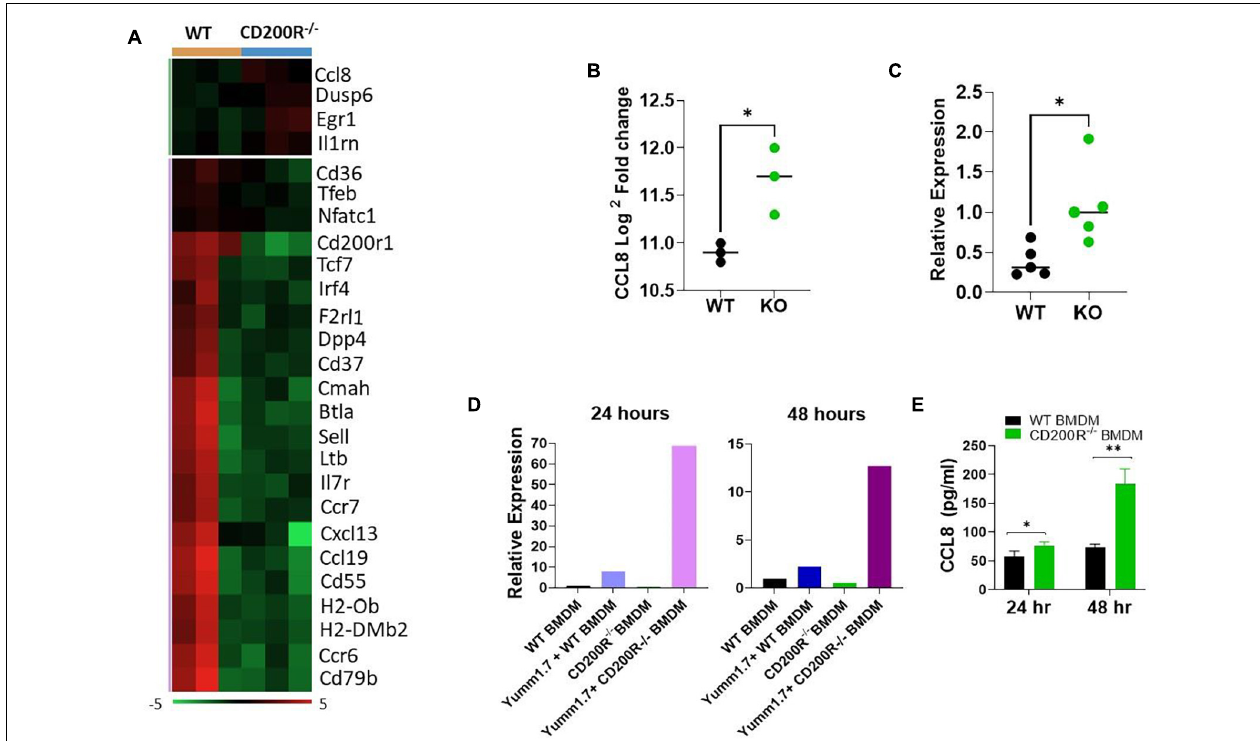
FIGURE 3 | Deficiency of CD200R signaling alters TME and upregulates CCL8. (A) Heat map of all differentially expressed genes based on the Nanostring analysis. (B) CCL8 gene expression was significantly elevated in CD200R − / − vs. wild type tumors based on the Nanostring analysis ( ∗ P = 0.022 by two-sided Student’s t -test). (C) qPCR was used to quantify CCL8 gene expression in tumors ( n = 5/group) from wild type vs. CD200R − / − mice. ∗ P = 0.042 by two-sided STUDENT’s t -test. (D,E) Bone marrow derive macrophages (BMDM) was generated and co-cultured with YUMM1.7 tumor cells. qPCR was used to quantify CCL8 gene (D) expression in macrophages, and ELISA was used to quantify CCL8 protein (E) production in culture supernatants. CCL8 gene expression or protein production in BMDM alone or YUMM1.7 tumor cell alone were low or undetectable. ∗ P = 0.05; ∗∗ P = 0.0019 by two-sided Student’s t -test.